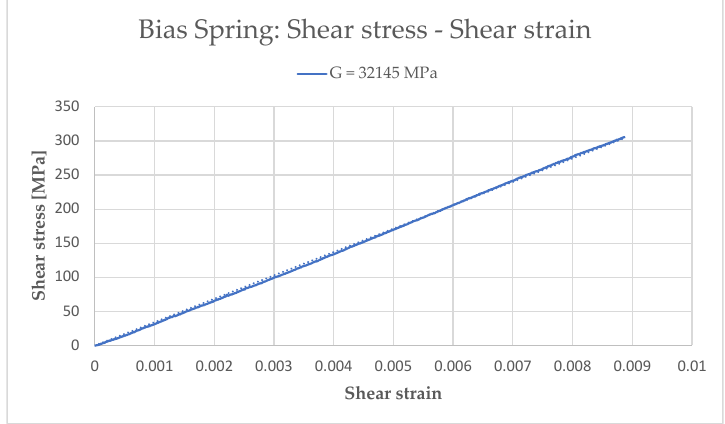
Figure 7. Shear stress–shear strain curve and corresponding shear modulus G. Table 1. Mechanical and material properties of the bias spring.